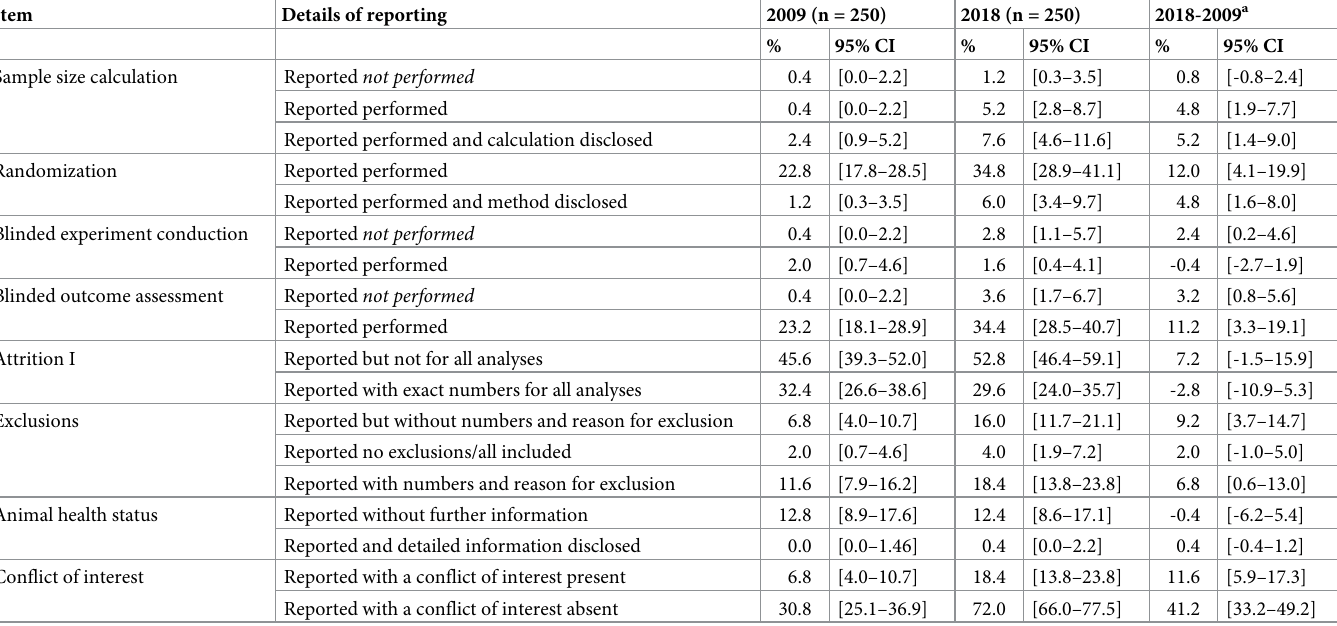
Table 1. Prevalence of reporting details in Danish preclinical research in 2009 compared to